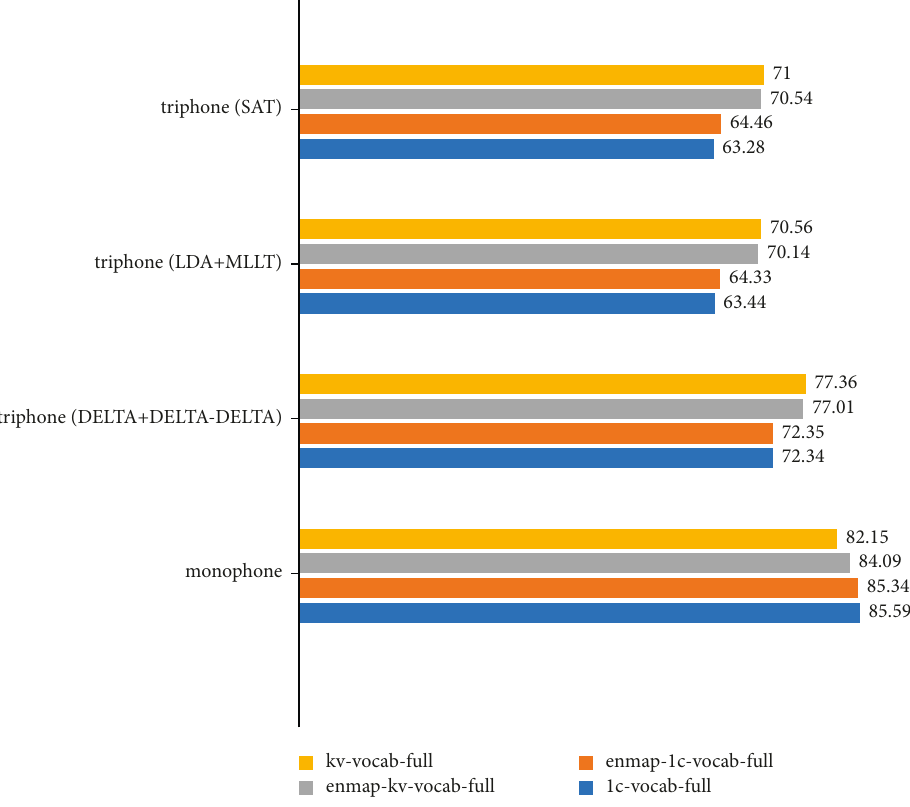
Figure 9: The %WER comparison for different GMM-HMM models using 30,000 unvalidated utterances. Table 12: The performance of the acoustic models using 46,550 validated